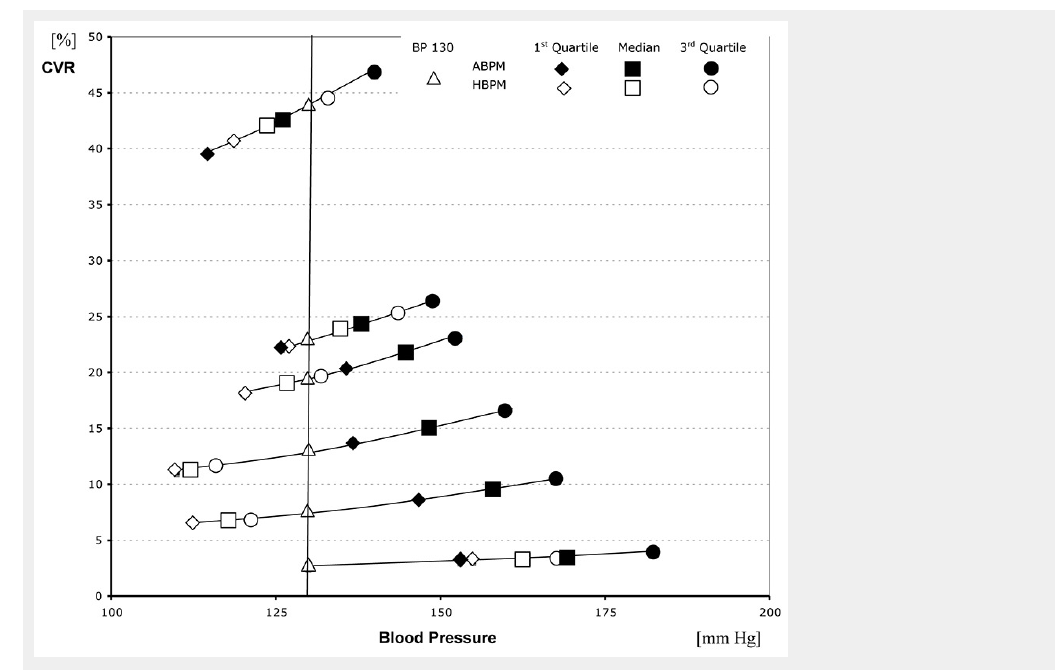
Figure 3 Examples from six participants (1 to 6 ) of the estimation of CVR by use of the PROCAM formulae, abscissa: blood pressure (mm Hg), ordinate: cardiovascular risk (%) according to the PROCAM algorithm, i.e. risk for myocardial infarction within a period of 10 years. PROCAM risk categories: low risk (<10%), medium risk (10–20%), high risk (>20%). Moderate changes in systolic BP (mm Hg) lead to very low modifications of CVR. A “basic risk” was calculated as the CVR associated with 130